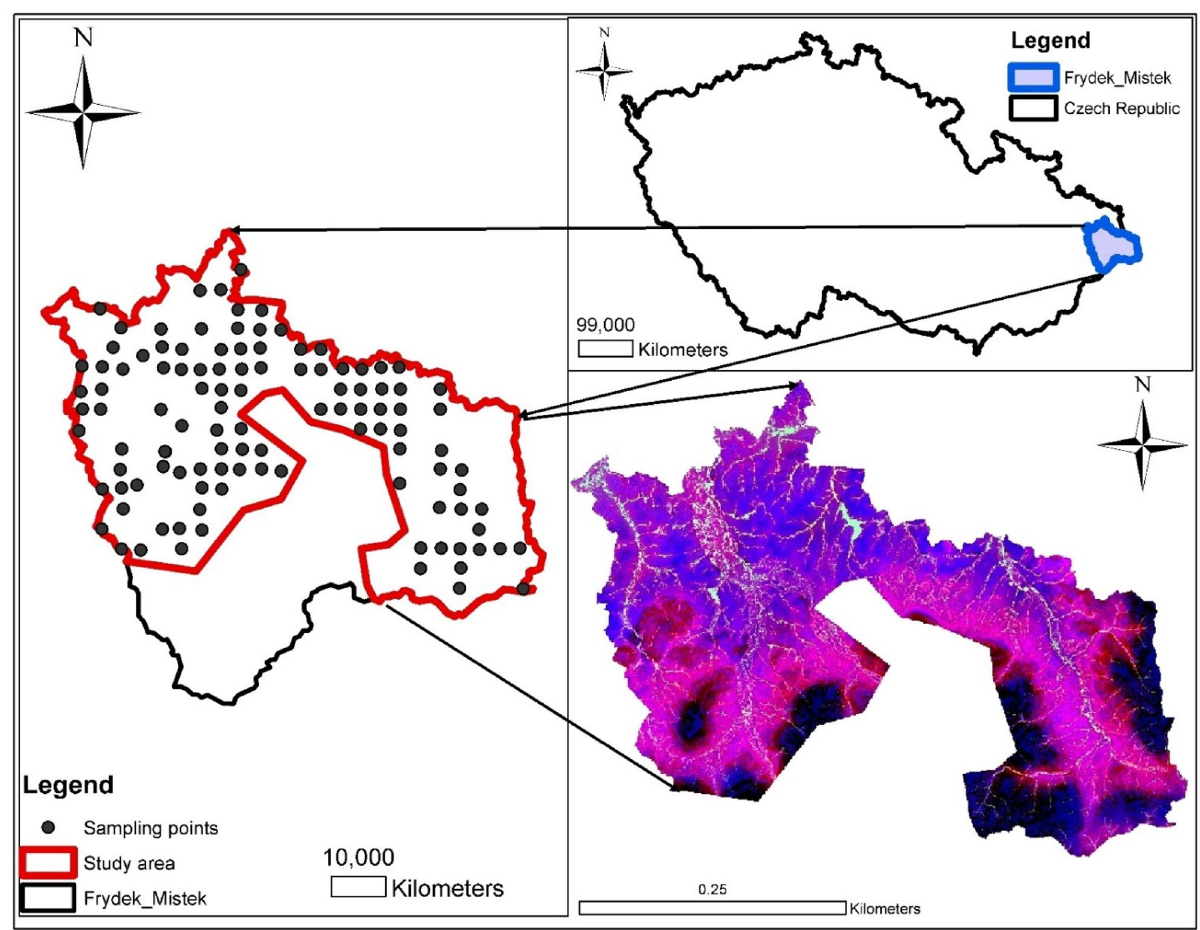
Figure 1. Study area map [The study area maps was created with ArcGIS Desktop (ESRI, Inc, Version 10.7, URL: https:// deskt op. arcgis.